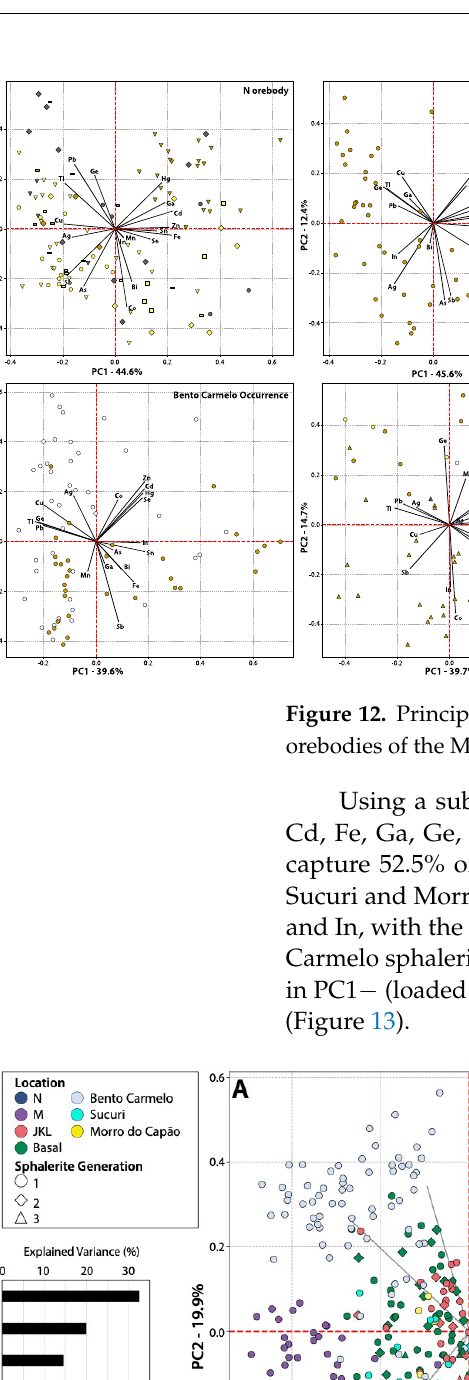
Figure 11. Plot of sphalerite analyses in PC1 (29.2%) vs. PC2 (13.0%) ( A ) and the element compo- nents ( B ) with the eigenvalues of the PCs on the left.